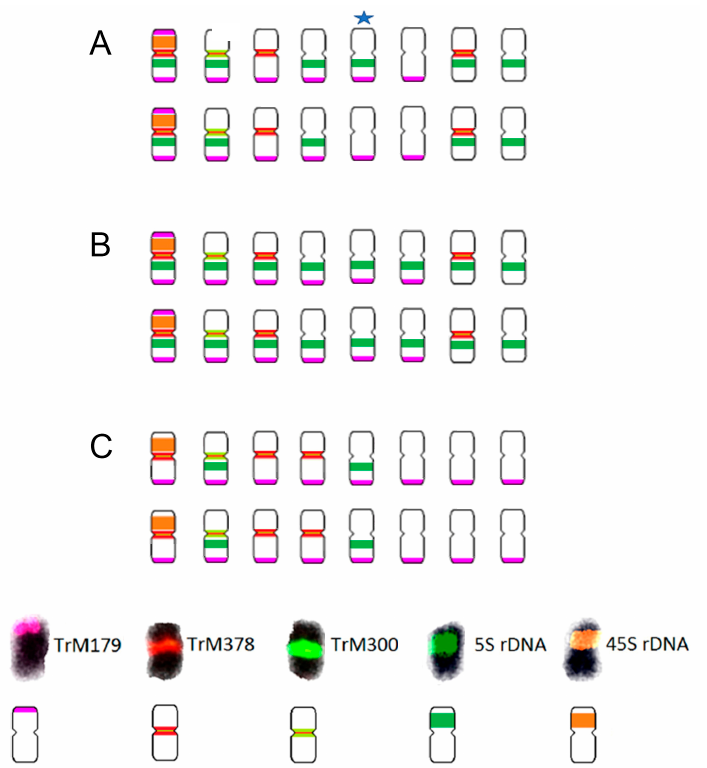
Figure 8. Schematic karyotypes of ( A ) T. alpestre , ( B ) T. pignantii , and ( C ) T. rubens based on the hybridization patterns of probes derived from 5S (dark green) and 26S (orange) rDNA; subtelomeric